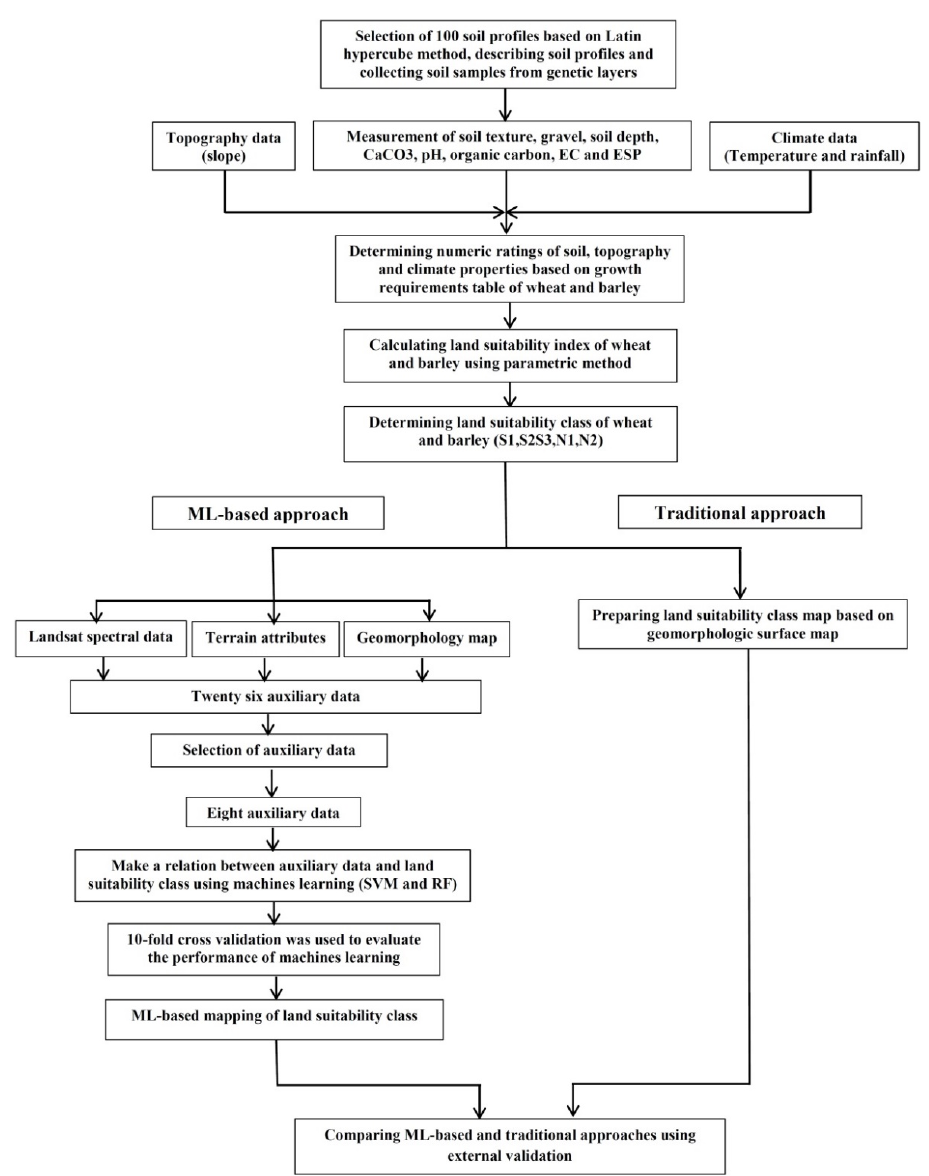
Figure 2. Flowchart of methodology used for machine learning (ML)-based and traditional land suitability assessment in this study. SVM: support vector machine; RF: random forest.